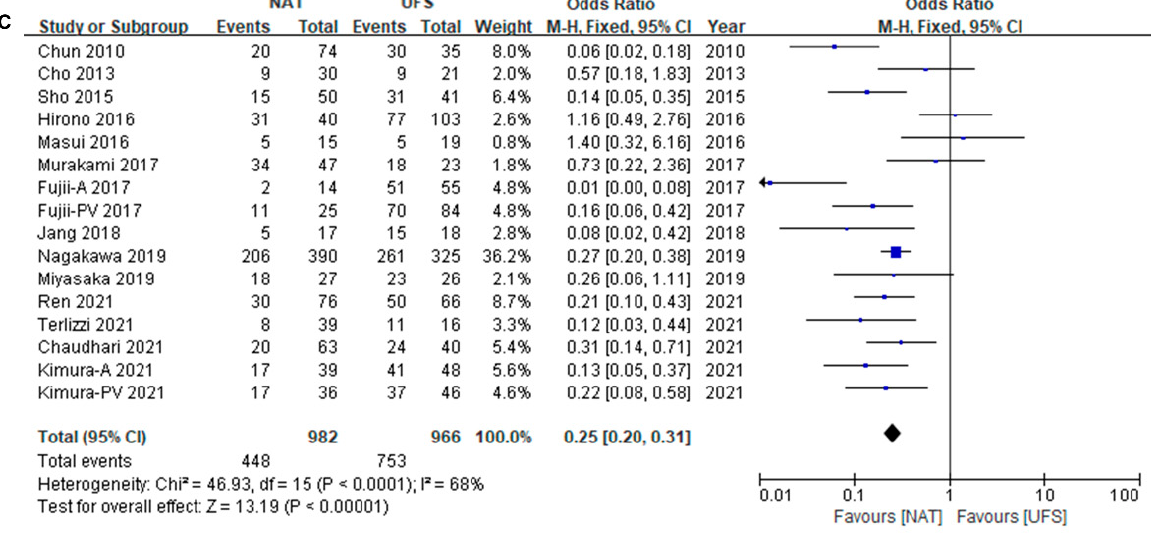
Figure 4. ( A ) Resection rate of NAT versus UFS in total patients. [6,10,12,20,21,23–29,31] ( B ) R0 resection rate of NAT versus UFS among resected patients. [9,10,17–21,24–31] ( C ) Pathological lymph node rate of NAT versus UFS among resected patients [9,10,12,17–21,24,25,28–31]. Blue squares correspond to individual studies. Squares size is proportional to the weight of the study while black diamonds shapes correspond to pooled studies.